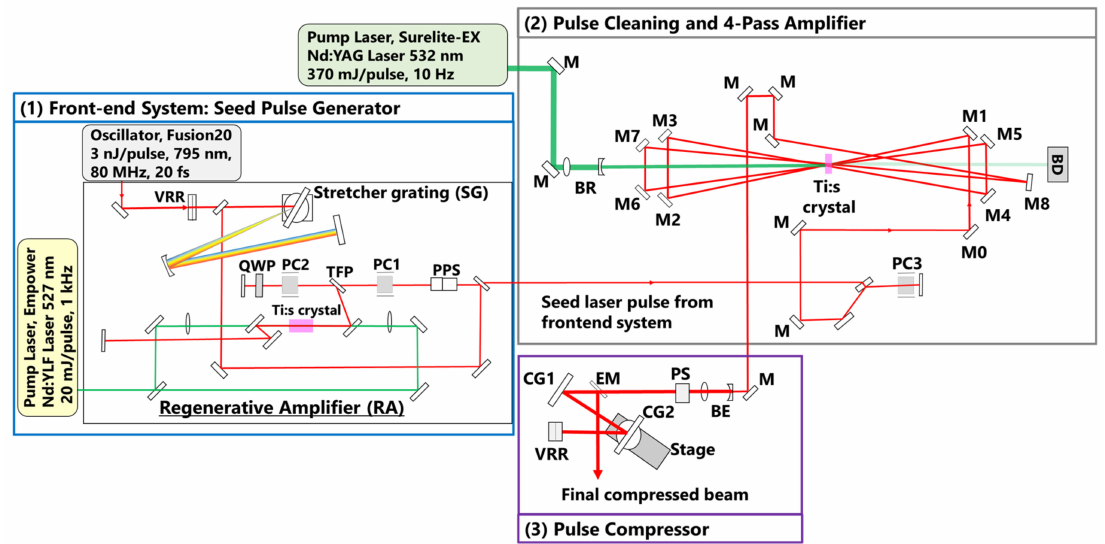
Figure 1. Schematic of the 1 TW/35 fs Ti:sapphire laser amplifier system. VRR: vertical retro-reflector, PPS: polarization periscope, TFP: thin film polarizer, QWP: quarter-wave plate, M: mirror, BD: beam dump, BE: beam expander, BR: beam reducer, PS: periscope, PC: Pockels cell, CG: compressor grating, EM: exit mirror.